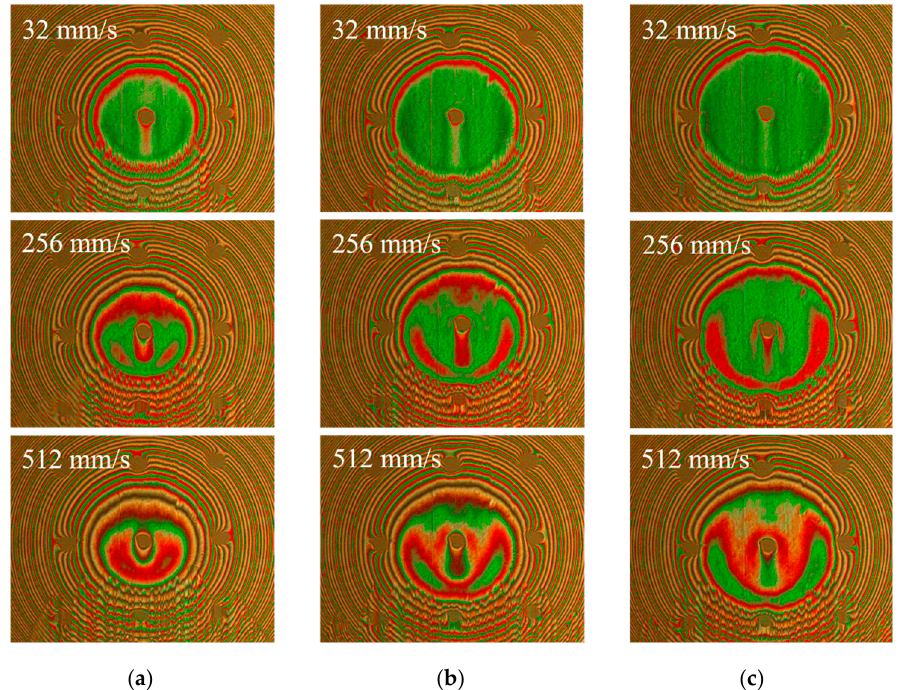
Figure 7. Interference images of sample 1 with dimple located at the middle of contact area under different loads: ( a ) 8.3 N; ( b ) 16.7 N; ( c ) 25